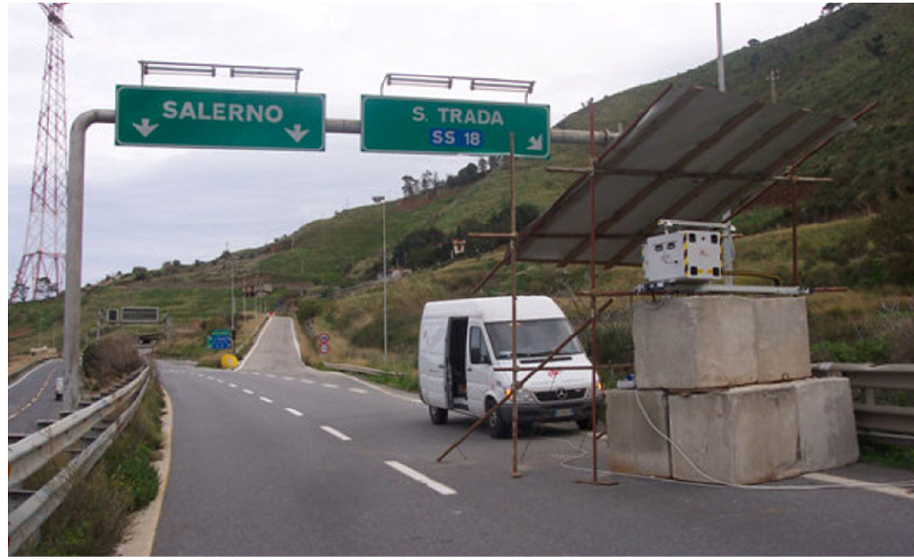
Fig. 4. Photograph of the GB-InSAR system installed on the motorway nearby Santa Trada.